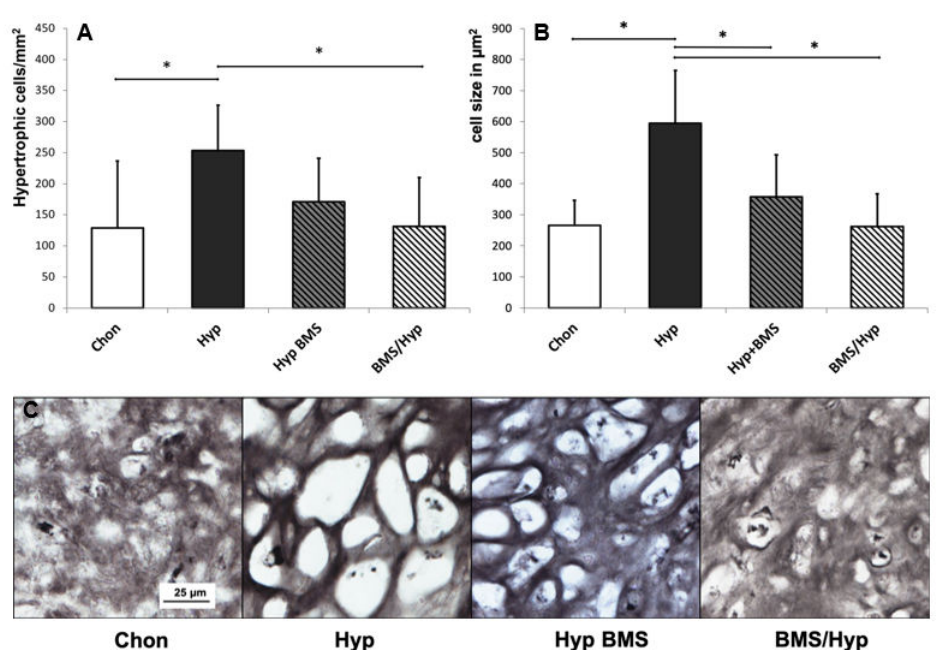
Figure 4. E ff ect of BMS on the number and size of hypertrophic cells. Image morphological determination of ( A ) number of hypertrophic cells relative to aggregate area; and ( B ) average cell size of hypertrophic cells in histological sections; ( C ) 40x magnification of the immunohistochemical collagen type II stained histological sections for illustration of hypertrophic chondrocytes under BMS treatment. n = 3. Whiskers represent standard deviations. Significant di ff erences (* p < 0.05) are designated by asterisks. Scale bar = 25 µ m. Chon, chondrogenic control group; Hyp, hypertrophic control group; Hyp BMS, hypertrophic group with late BMS treatment; BMS / Hyp, hypertrophic group with early BMS